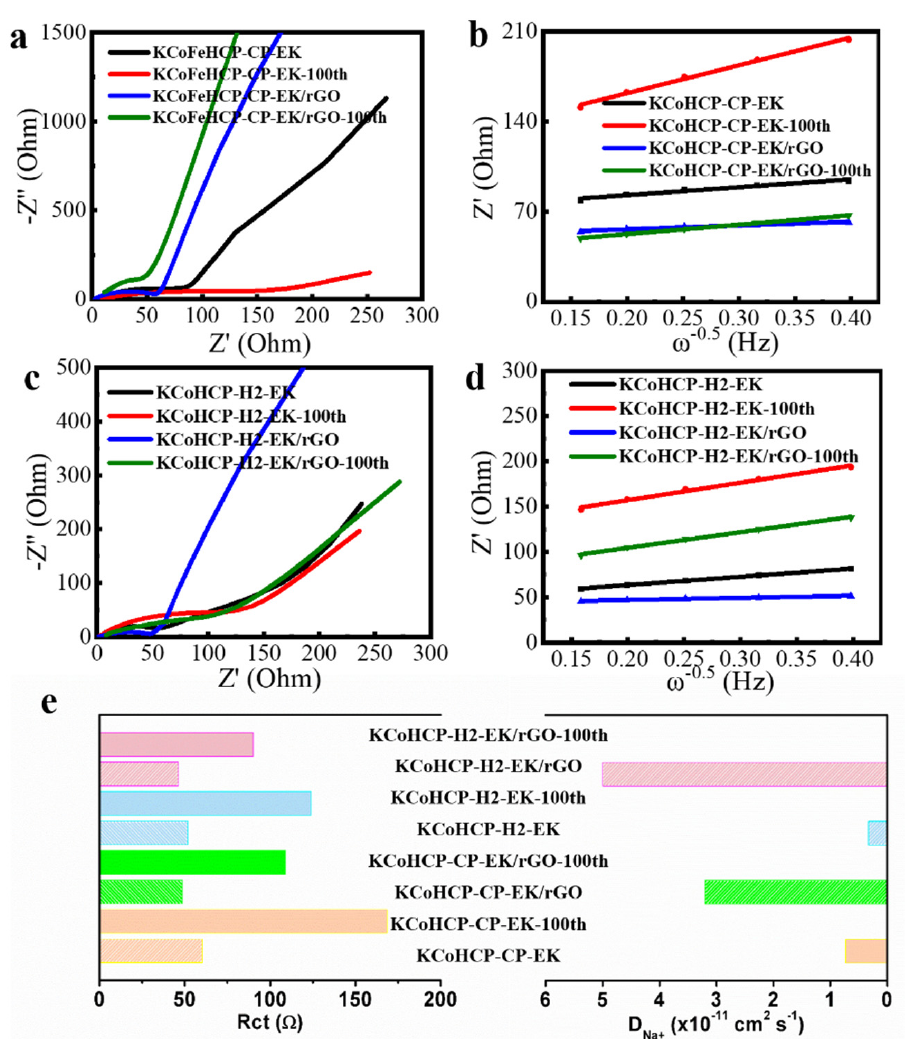
Figure 5. ( a , c ) Nyquist plots of different samples; ( b , d ) the liner fitting between Z’ and ω − 0.5 at low − frequency region of different samples; ( e ) the calculated R ct and D Na+ values.